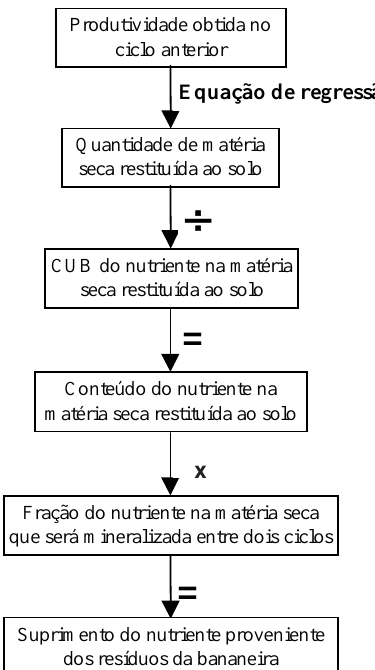
Figura 3. Fluxograma que indica como se estima, a partir do segundo ciclo de produção, o suprimento de um nutriente proveniente dos resíduos da bananeira (matéria seca restituída ao solo = rizoma + pseudocaule + folhas + coração + “ráquis